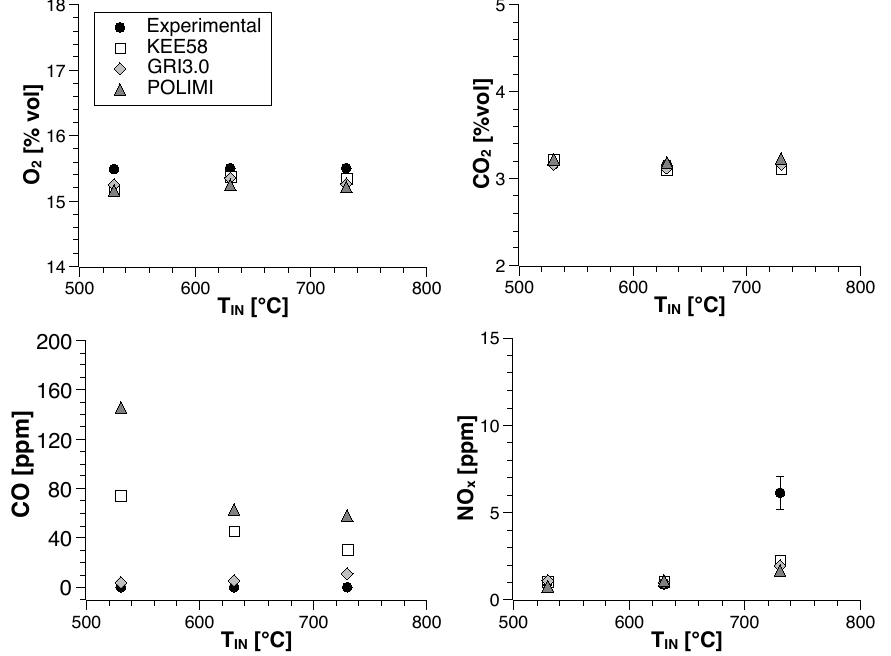
Figure 18. Comparison between measured and computed values of O 2 (% vol), CO 2 (% vol), CO (ppm), and NO x (ppm) concentrations in the exhaust gas for different kinetic mechanisms at different air inlet temperatures. λ =